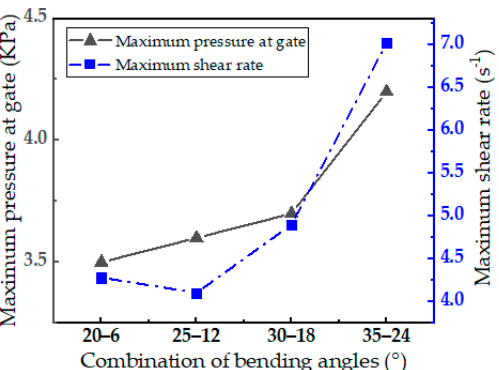
Figure 9. Variation in the maximum shear rate and the maximum pouring pressure at the gate with changes in the combination of the bending angle.